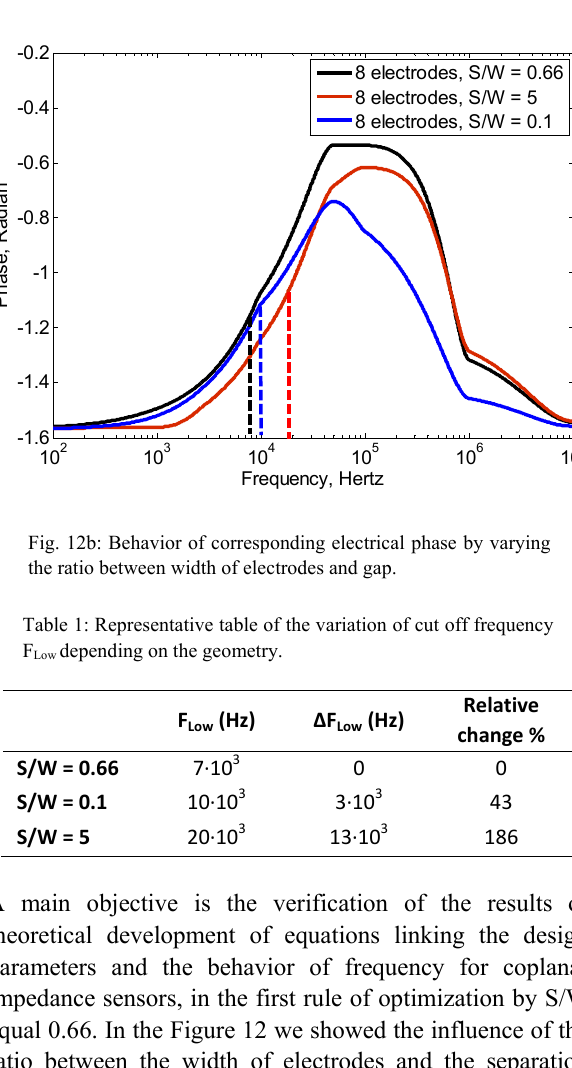
Fig. 11: Simulated response of interdigital biosensor with 16 electrodes, by changing the conductivity of the blood medium (layer 4). Electrical impedance simulated for two different conductivities, 0.7 S/m and 9 S/m, respectively.